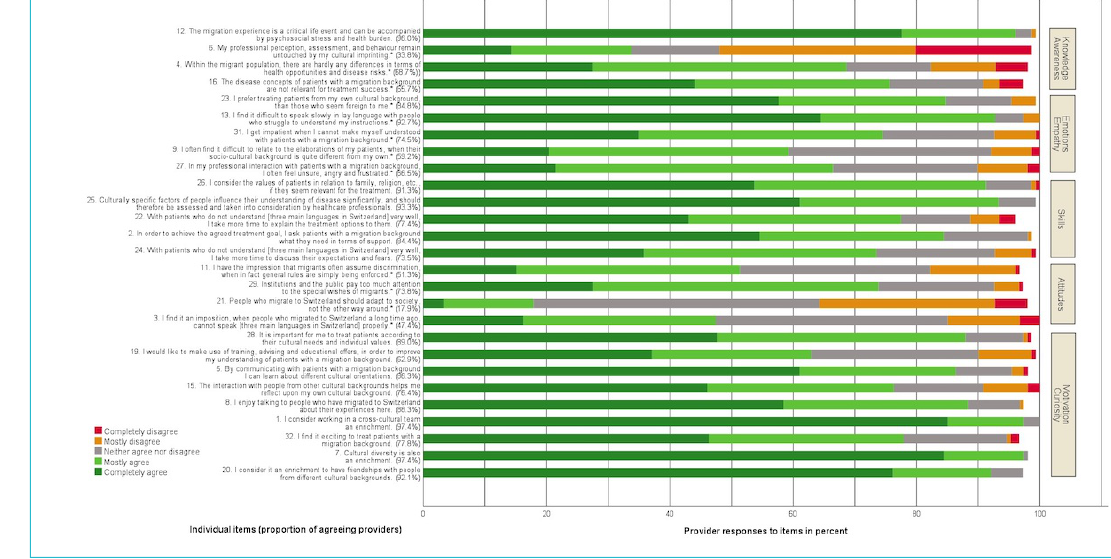
Figure 2: Agreement and disagreement with the 27 items of the Cross-Cultural Competence of Healthcare Professionals (CCCHP) question-